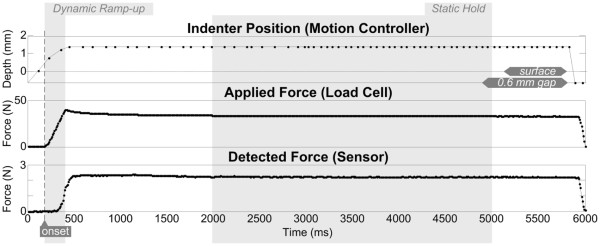
Data collected during a ~5 s ramp-and-hold indentation. Indentation was provided via a flat indenter tip, 1.4 mm into the surface of the sensor-substrate. Indenter tip starts from an initial position of 0.6 mm above the elastic-substrate’s surface. Phases of dynamic ramp-up and static hold are highlighted in gray.